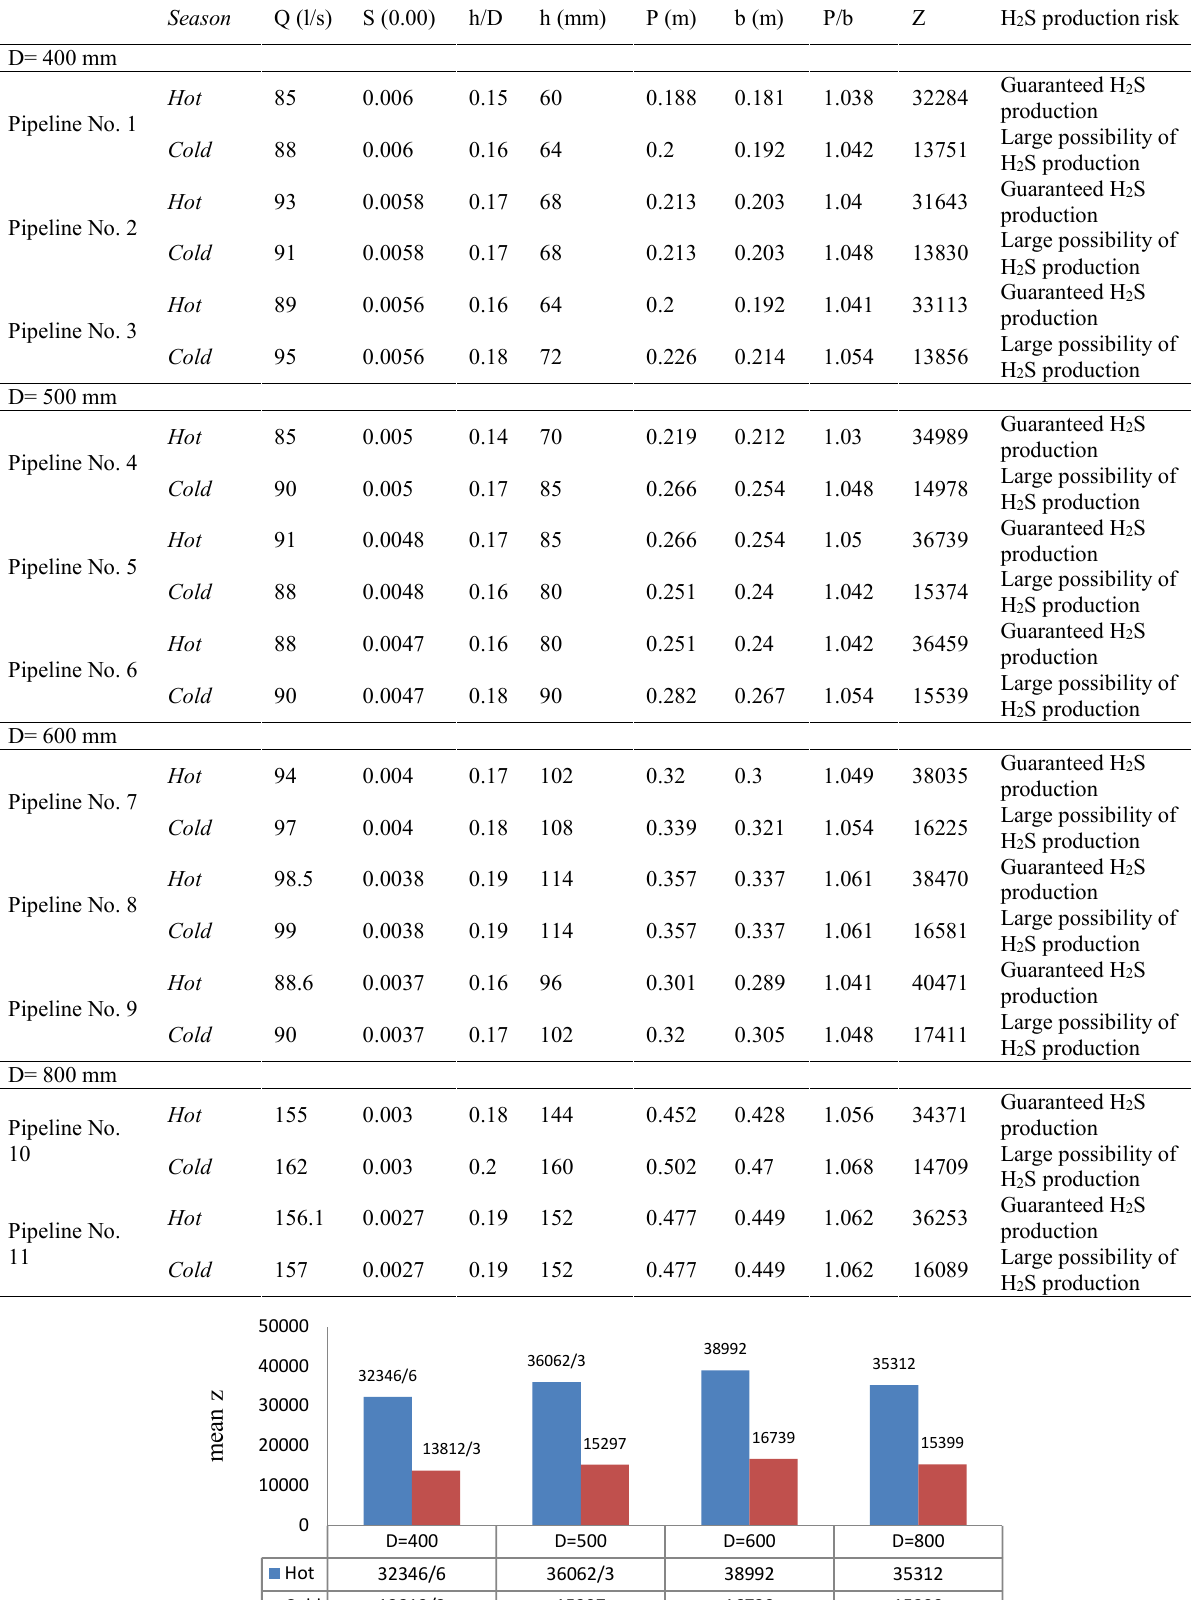
Fig. 1. Mean Z Value in Warm and Cold Seasons in Different Diameters of Pipes